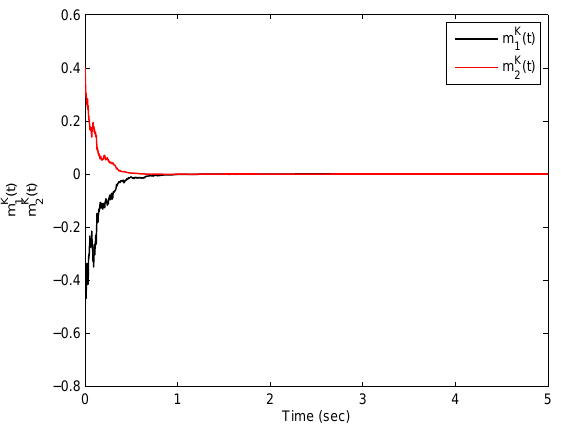
( t ) , m K ( t ) pertaining to the SMQVNN 2 1